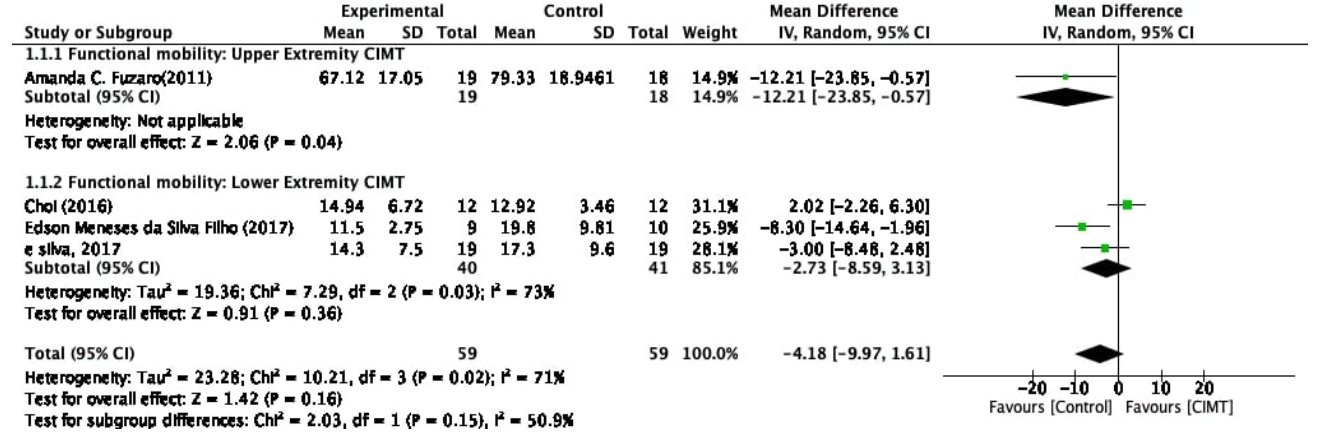
Figure 4. Meta-analysis results on the effect of CIMT on functional mobility among stroke popula- tion.